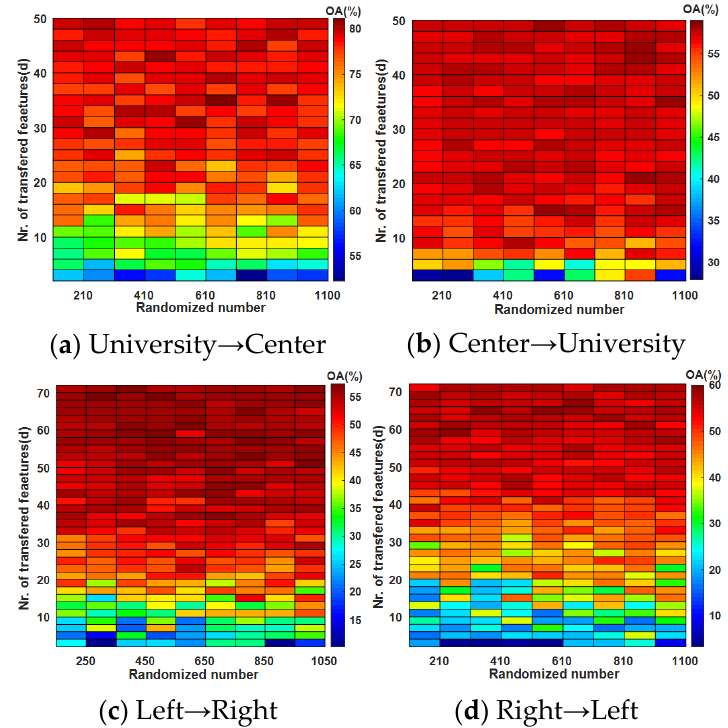
Figure 6. OA versus the parameters m and d of rPCA in GFKSVM for ROSIS ( a , b ) and Houston ( c , d ) data sets: (Source → Target).